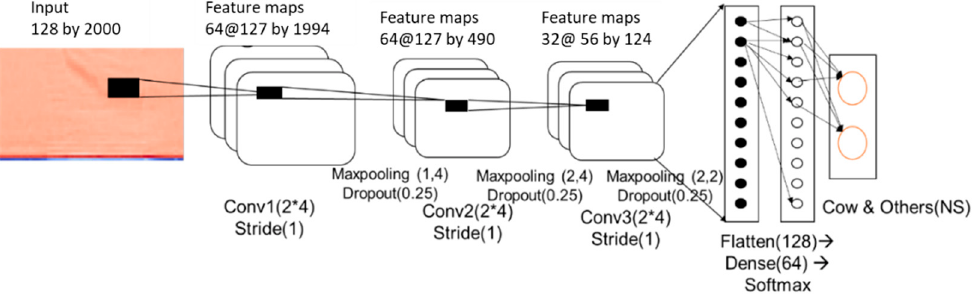
Figure 5. Two-dimensional convolutional neural network (CNN) model for classifying cattle voice and other noises.